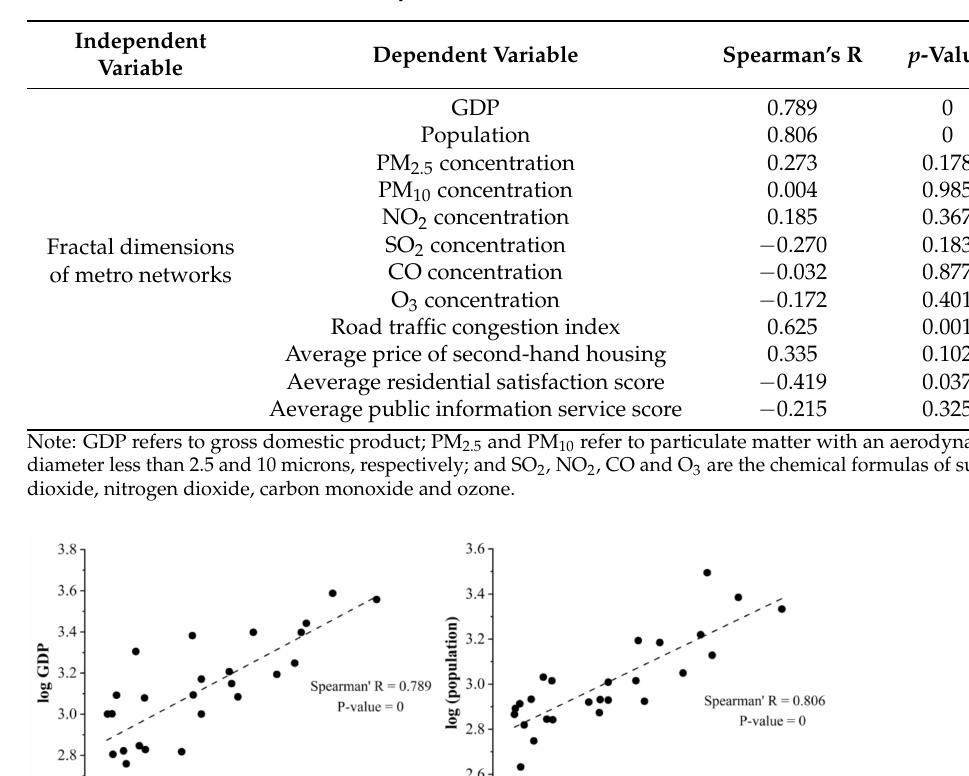
Table 3. The results of allometric analysis for 26 cities in China.